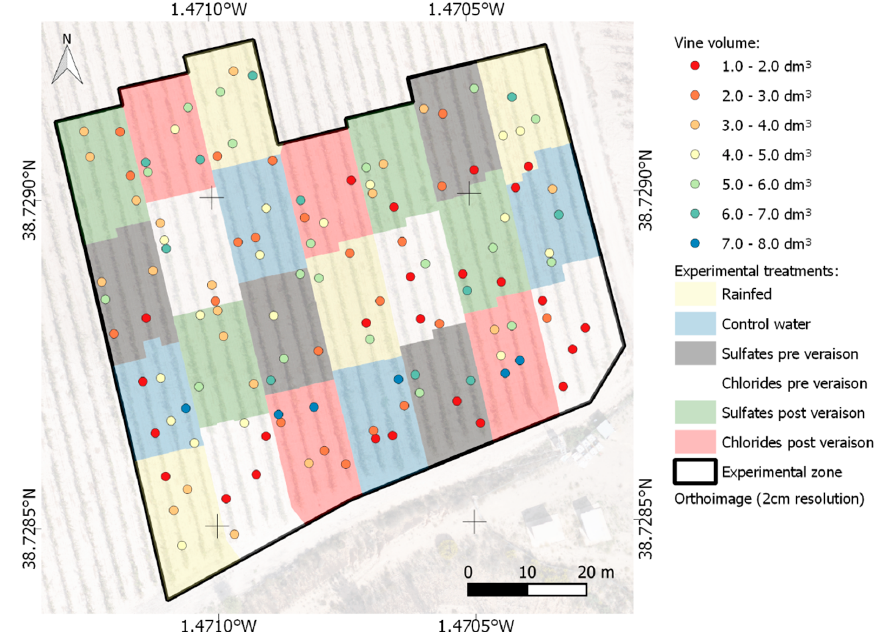
Figure 11. Calculated vine size map (scale 1:1000, EPSG:3857).